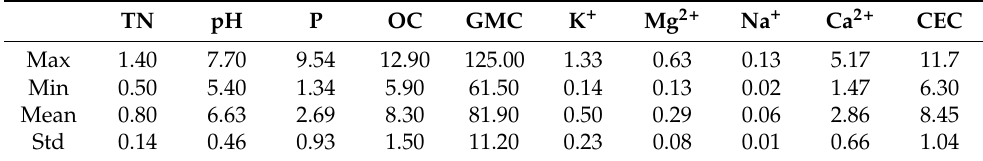
Table 2. Statistics of the measured soil properties of the 140 soil samples used as input data into the three